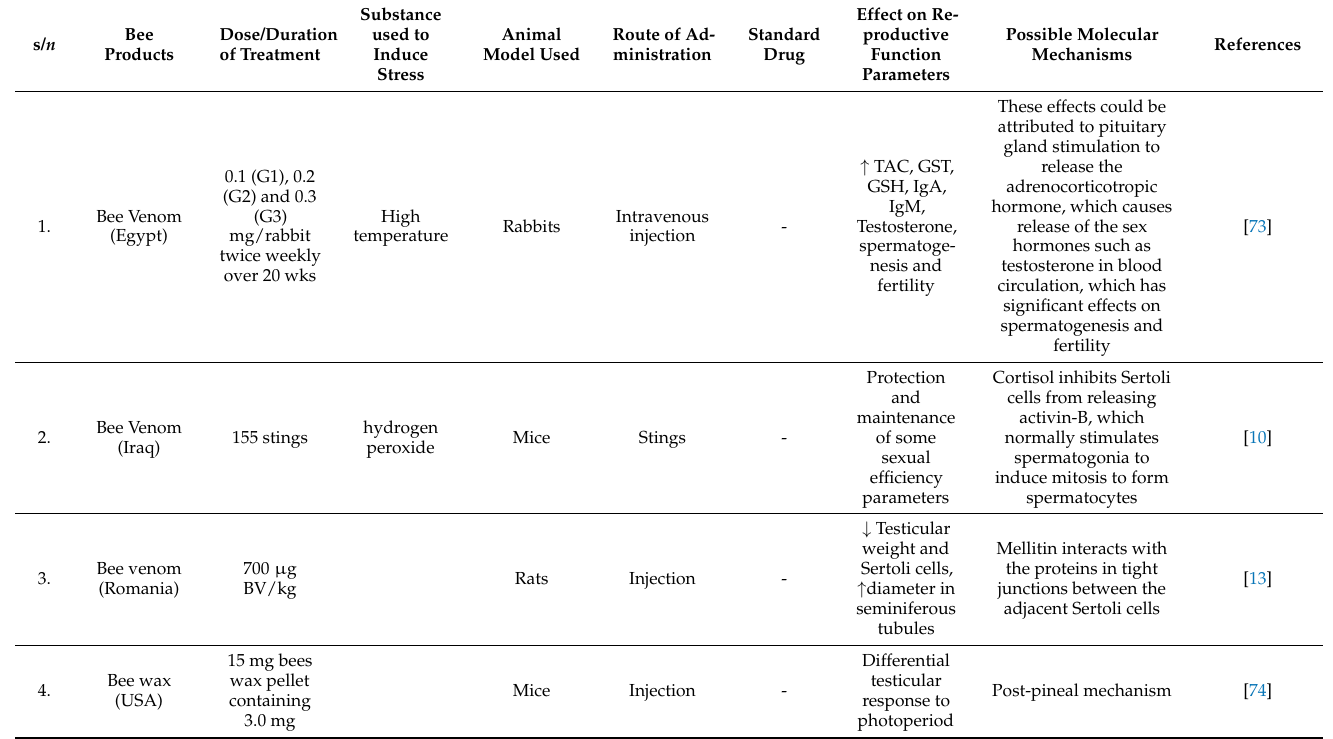
Table 2. Effects of bee venom and bee wax on male reproductive